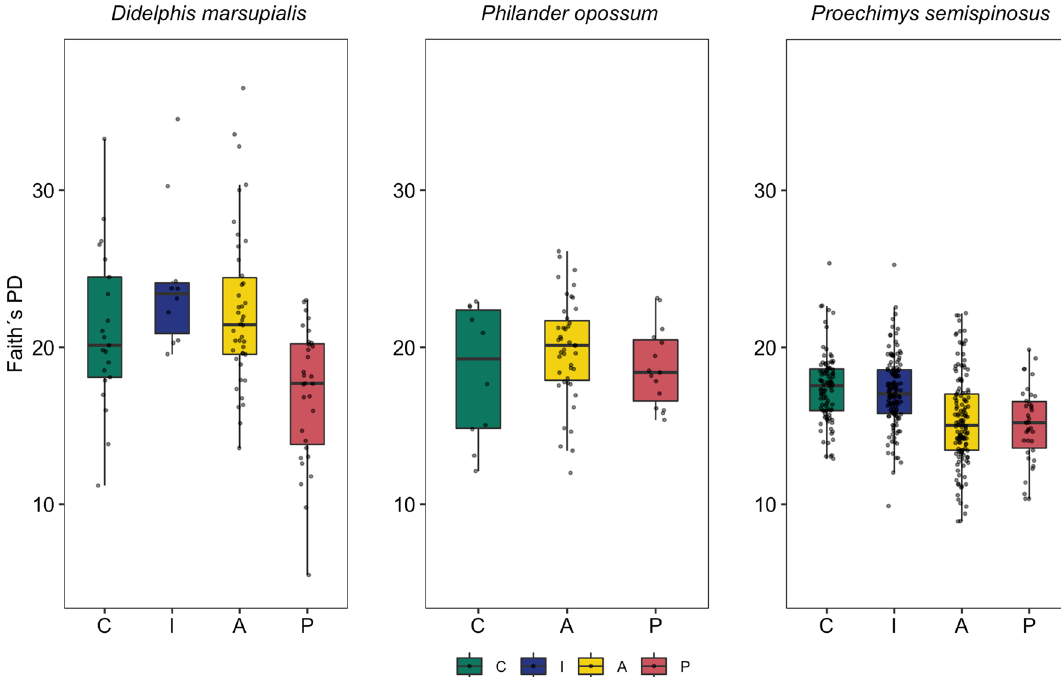
Fig. 3 Landscape effects on alpha diversity (measured as Faith´s PD) of three sympatric generalist species, the marsupials D. marsupialis and P. opossum , and the spiny rat P. semispinosus . Individuals were trapped in protected continuous tropical forests (landscape C, green); protected forested islands in the Panama Canal (landscape I, blue); in the nearby unprotected forested fragments embedded in an agricultural matrix (landscape A, yellow) and in teak plantations (landscape P, red)